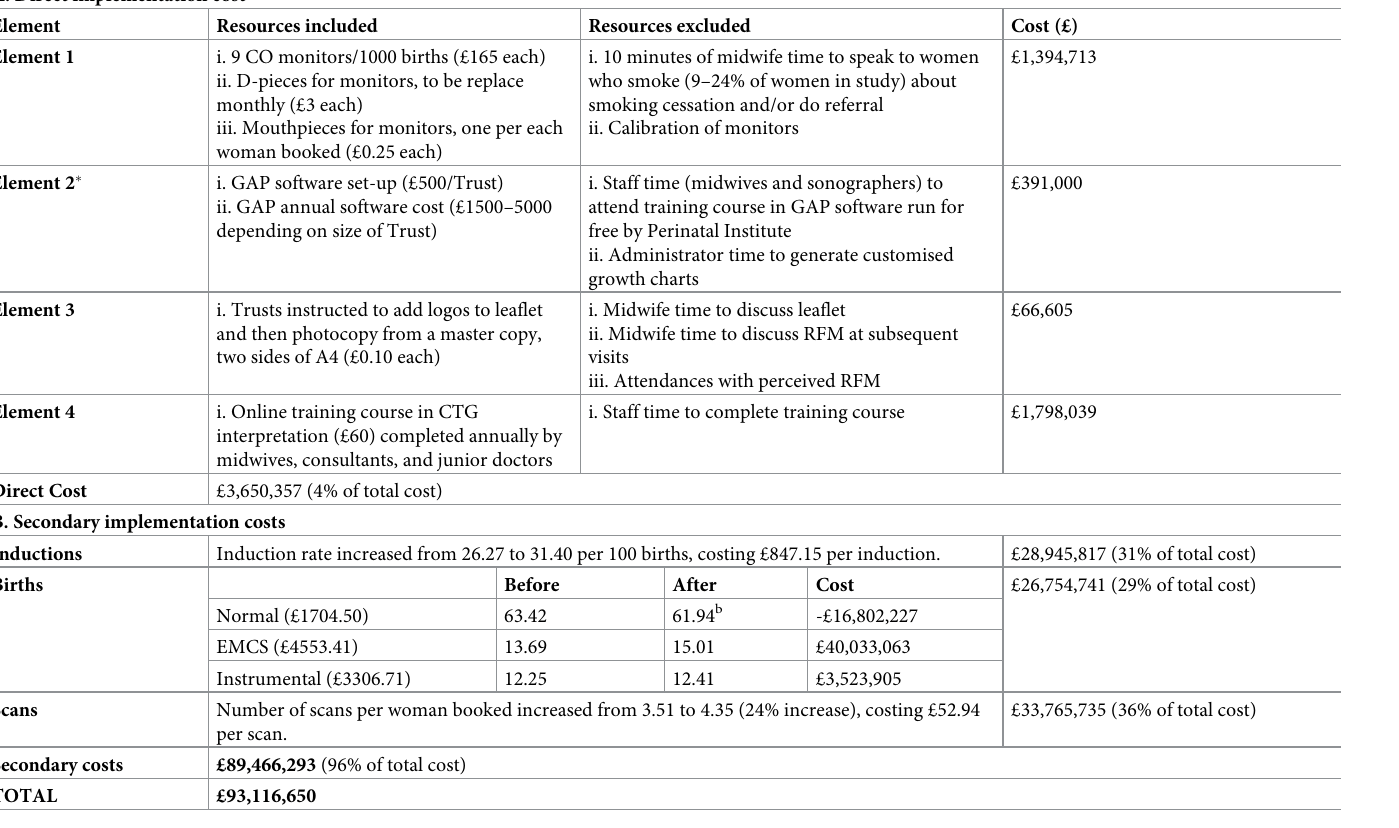
Table 5. Estimated annual costs for England associated with the SBL care bundle.